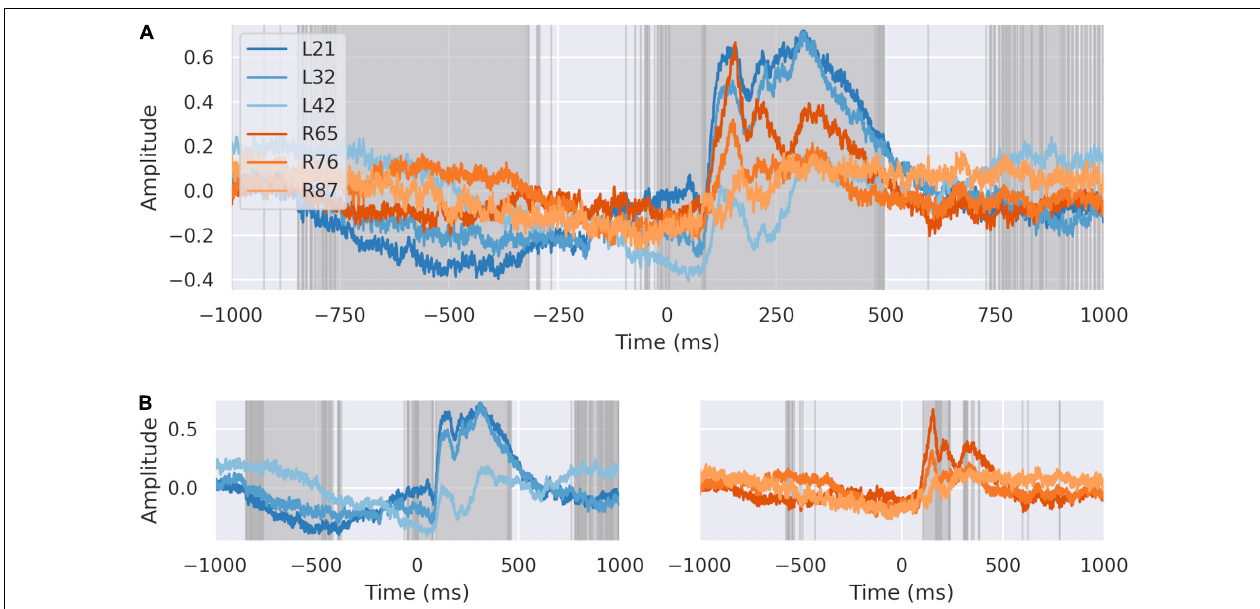
FIGURE 3 | The dACC response is distributed spatially. (A) The signals at each electrode plotted together. Highlighted regions demonstrate where differences between electrodes are statistically significant at p < 0:0001, Bonferroni corrected. All electrodes show coordinated activity during the –200 ms preparatory window. There are significant differences between individual electrodes in response recorded suggesting different response time courses in discrete populations. (B) Average response at left (blue) and right (orange) dACC. Highlighted regions are where the signal on electrodes within that side differ to a statistically significant degree. Individual regions differ in their response to feedback within the intervals we have identified, suggesting a spatial distribution in